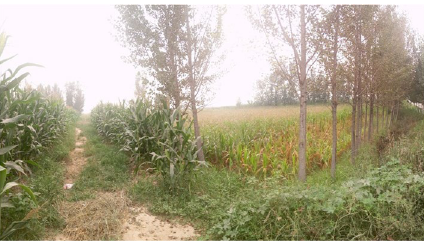
Fig. 2 Maize production in lowland and normal